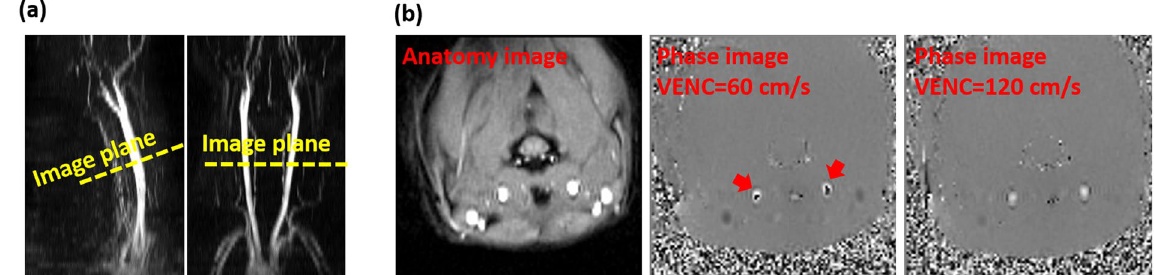
Figure 5. Illustration of the position of PC-MRI scans and representative images. ( a ) Example of PC-MRI slice position on the reconstructed sagittal and coronal view from the time-of-flight (TOF) angiogram. The yellow line indicates the image plane of PC-MRI at the level of middle of common carotid artery (CCA). ( b ) Anatomy and phase images from a representative rat. Red arrows indicate the phase aliasing when VENC of 60 cm/s was used. With higher VENC setting, the phase aliasing